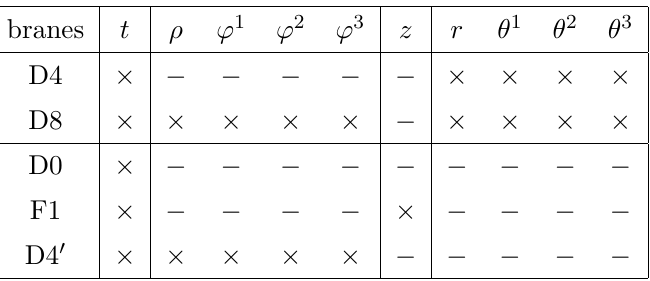
Table 2 . The brane picture underlying the 1d SCFT described by D0-F1-D4 0 branes ending on a D4-D8 system. The above intersection is 1 8